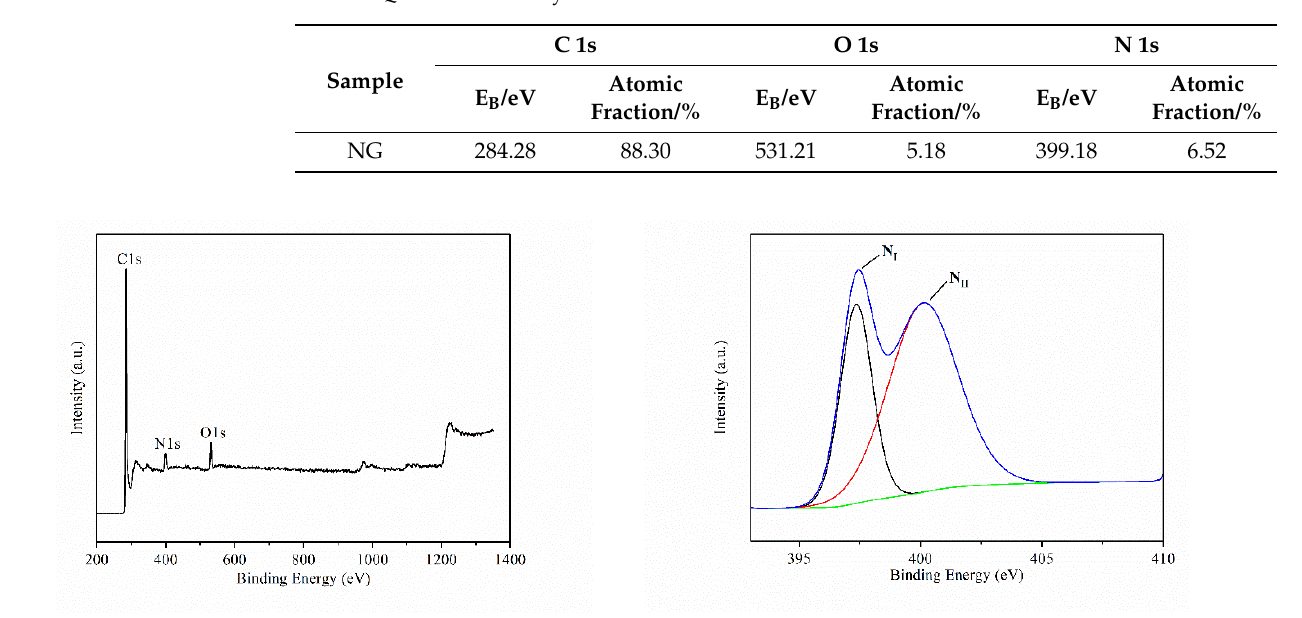
Figure 3. Analysis of morphology for PtRu/NG composite carbon nanofiber.